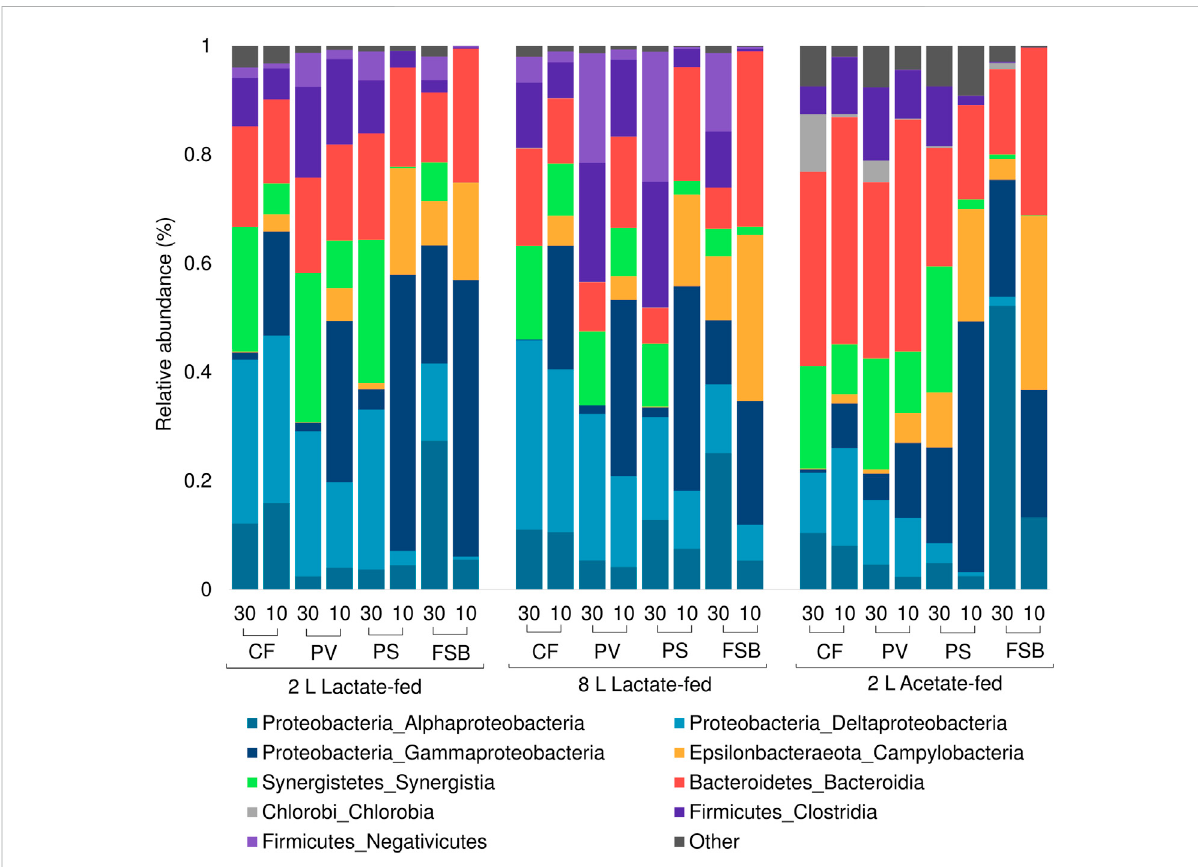
FIGURE 7 Taxonomic classi fi cation at phylum and class level showing the compositional shift in relative abundance of dominant af fi liated sequences in theCF,PV,PS,andFSBmicrobialcommunitiesasafunctionofdecreasingtemperaturefrom30to10 ° Cinthe2 Llactate-fed,8 Llactate-fed,and2 L acetate-fed